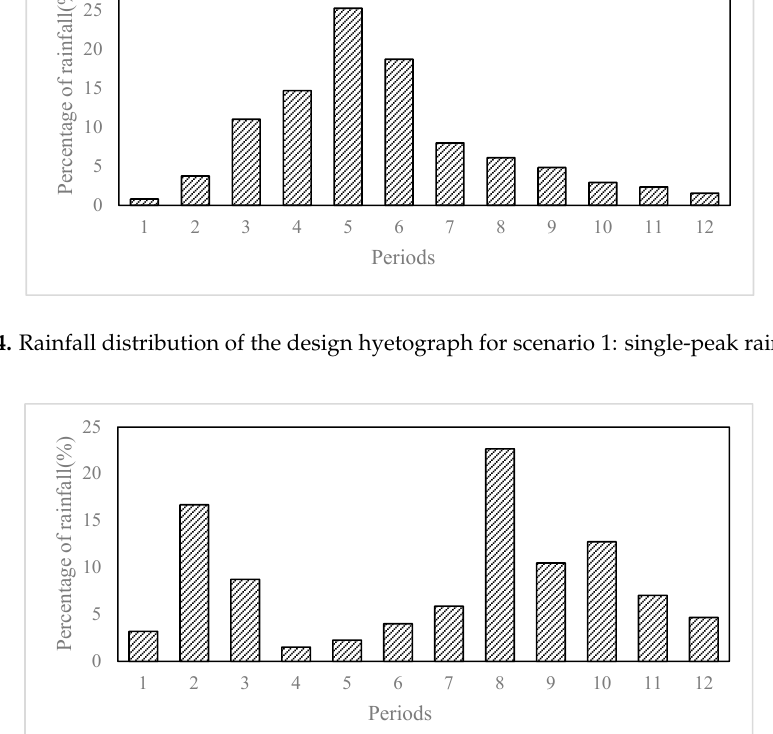
Figure 5. Rainfall distribution of the design hyetograph for scenario 2: double-peak rainstorms.